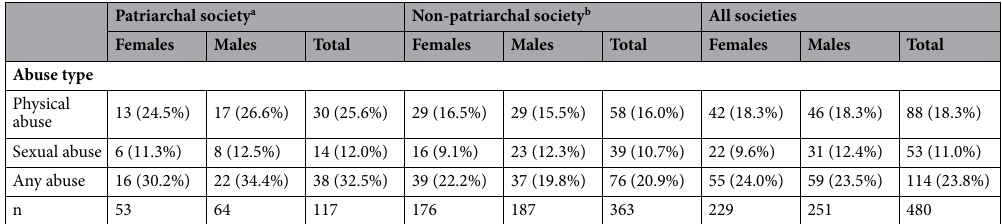
Table 3. Abuse experiences (physical, sexual) among participating adolescent Athletics athletes (n = 480) displayed by society and sex. a Asia, Africa, b Europe, the Americas,